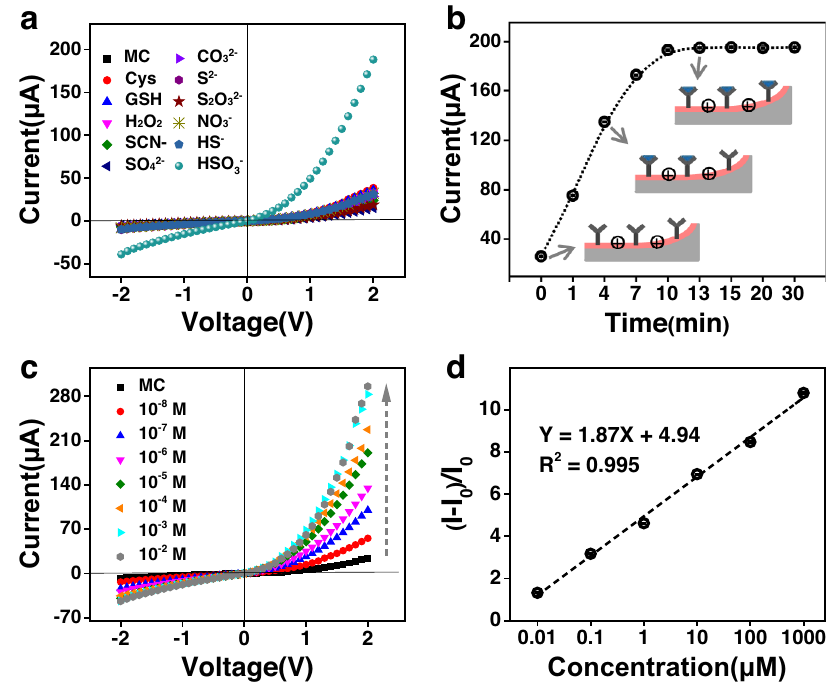
Fig. 6 | Performance of SP/AAO nanochannels in SO 2 detection. a Current changes for different analyte treatments. b Time-dependent current changes. c Concentration-dependentcurrentchanges. d Relationshipbetweenioniccurrent